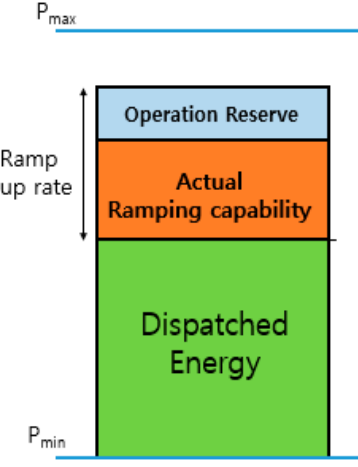
Figure 4. The practical ramping capability considering reserve constraints.